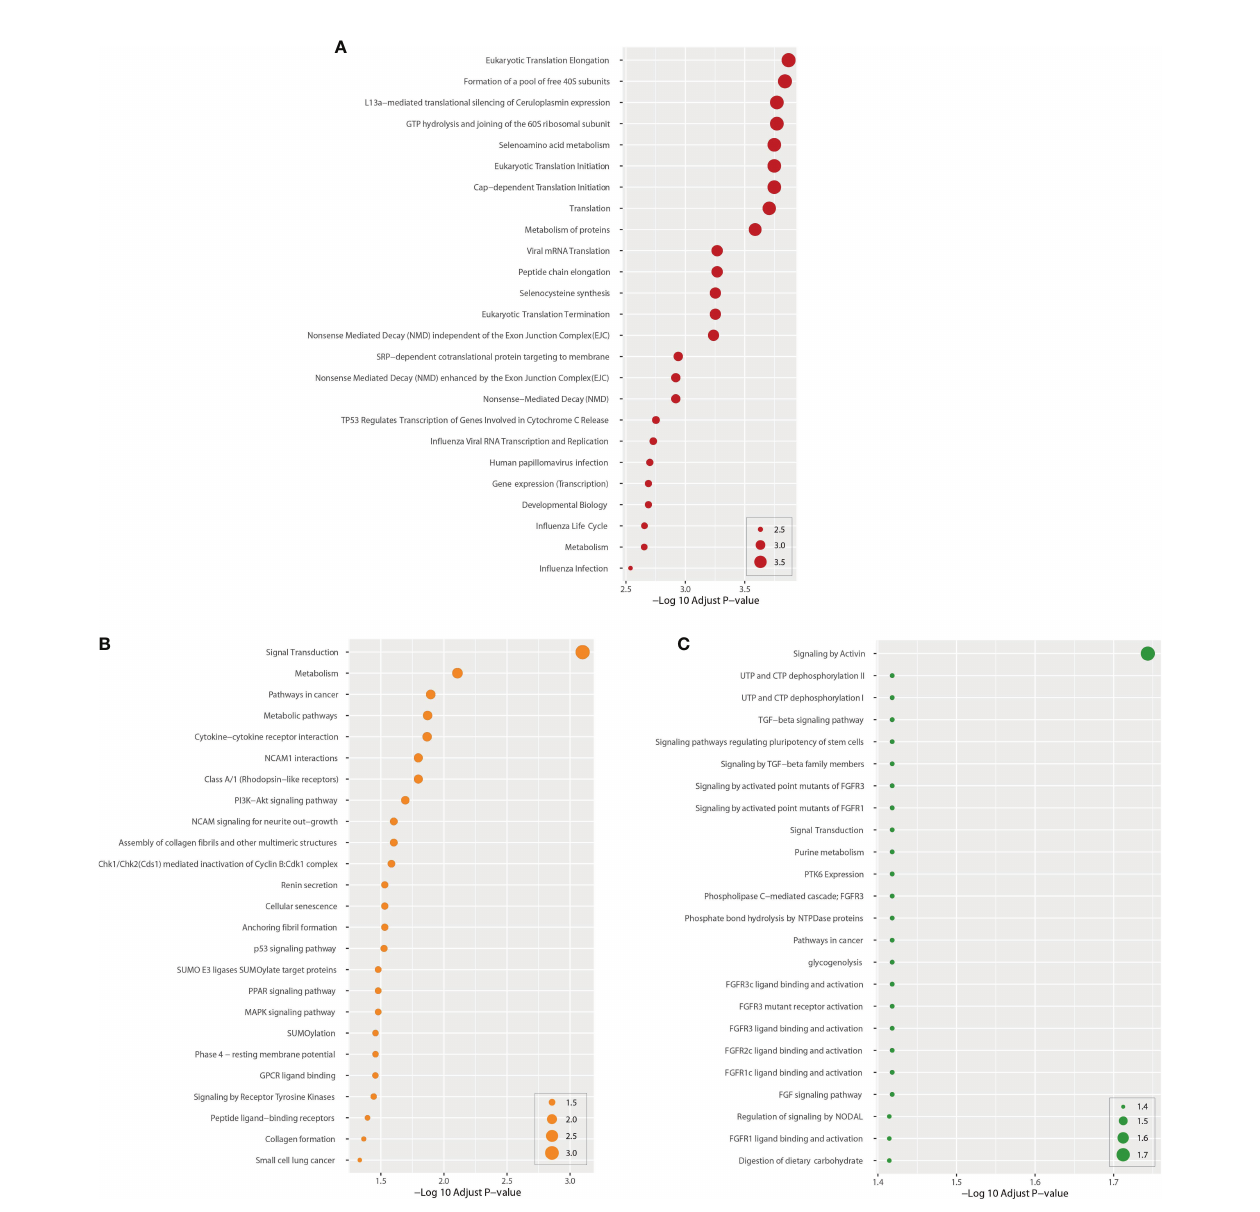
FIGURE 3 | Top 25 cascades between COVID-19 and psychiatric diseases. Cascades were determined using DEGs for each condition and COVID-19 whole blood and immune samples. Panel (A) shows cascades for BD. Panels (B, C) show pathways for SZ and LOD, respectively. The higher the log adj P , the more signi fi cant the